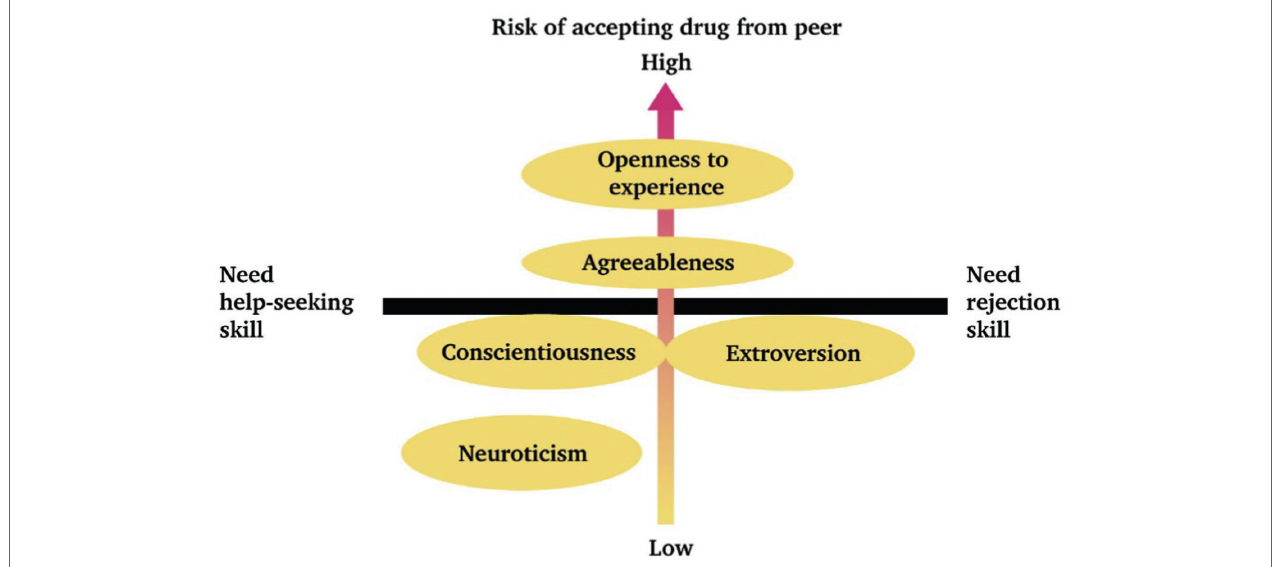
FIGURE 11 | Adaptive anti-drug education